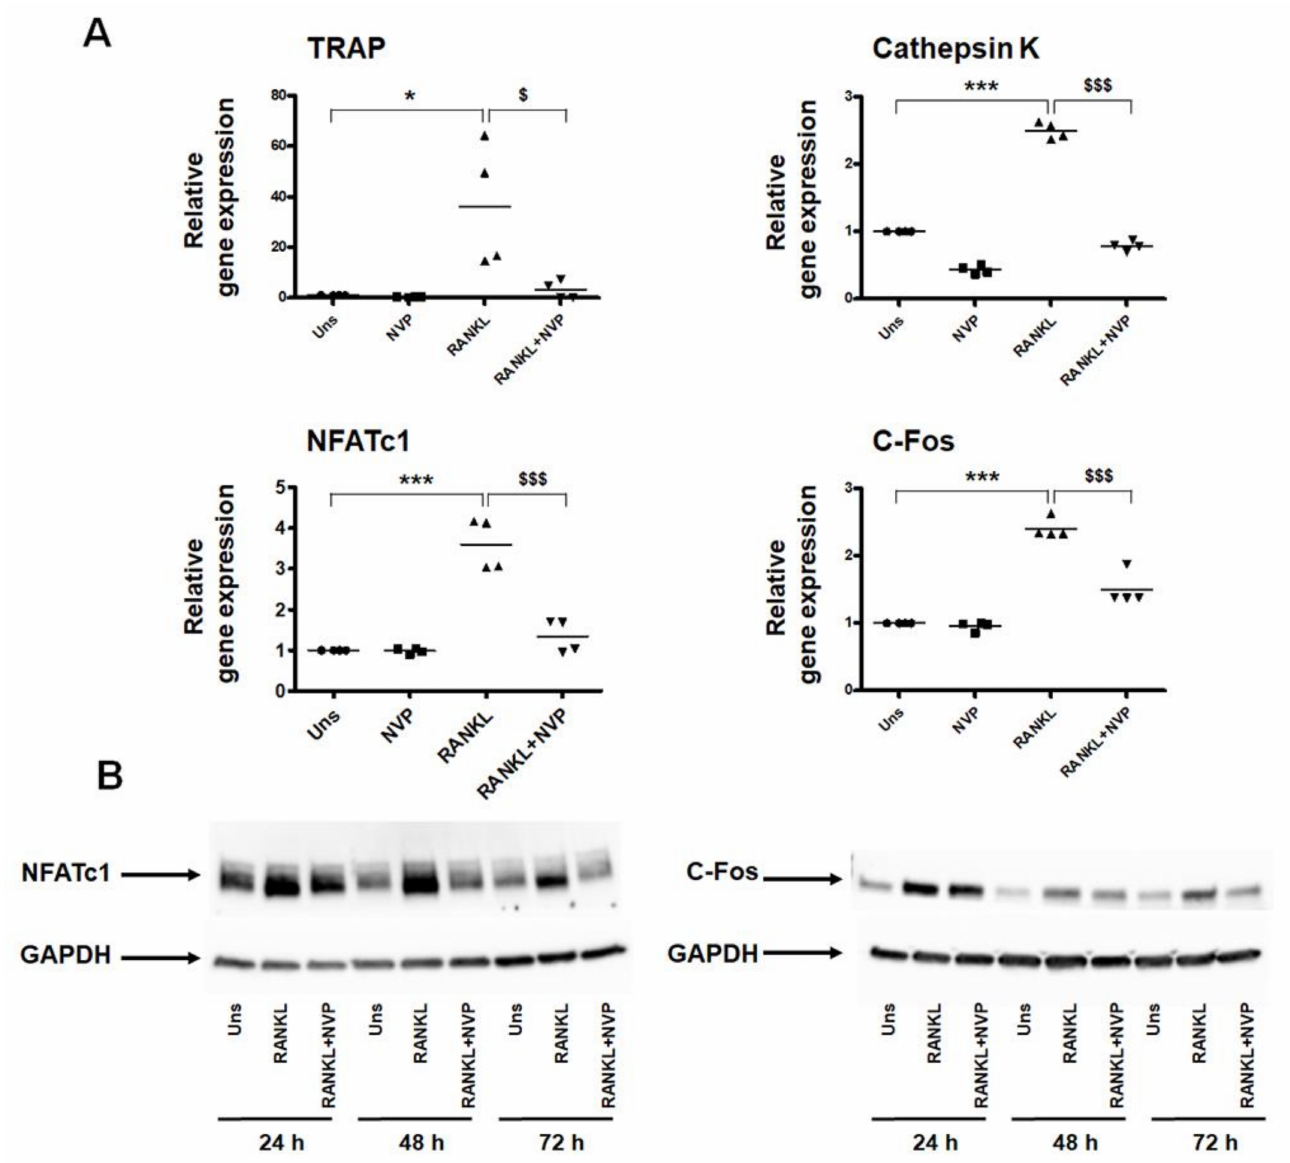
Figure 5. Effect of NVP on osteoclast markers. ( A ) RAW264.7 cells were stimulated for 72 h with RANKL (25 ng/mL), or RANKL in the presence of 5 mM of NVP (RANKL+NVP) as indicated. Total RNA was extracted and expression of TRAP, cathepsin K, NFATc1 and c-Fos were analyzed by real-time PCR, normalized to Rps18 and presented as the relative level to unstimulated cells (Uns). Data are expressed as the mean ± S.D ( n = 4). Symbols ( * , $) indicates statistical significance difference at p < 0.05, symbols (***, $$$) indicates statistical significance difference at p < 0.001. ( B ) Representative Western blot analysis showing NFATc1 and c-Fos expression after 24 h, 48 h and 72 h stimulation with RANKL (25 ng/mL), or RANKL in the presence of 5 mM of NVP